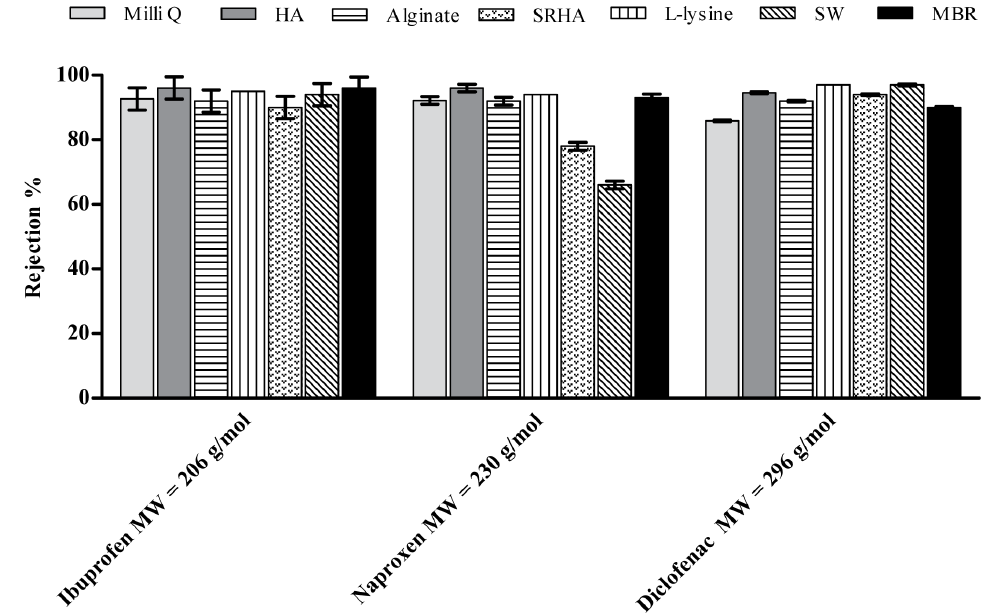
Figure 5. Rejection of hydrophobic ionic compounds by membranes fouled by various organic